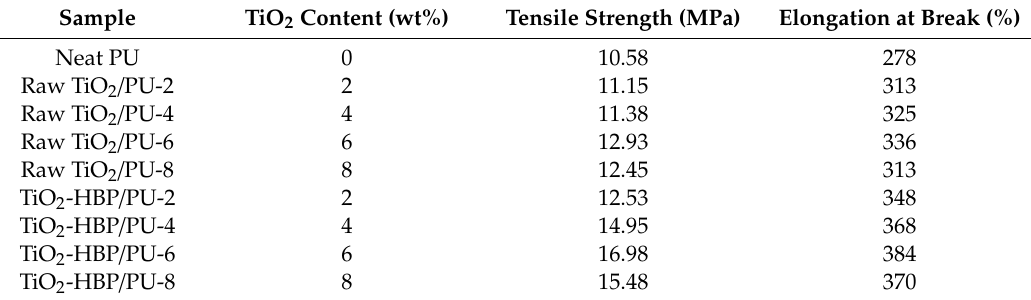
Table 1. Tensile strength and elongation at break of the nanocomposite coatings.